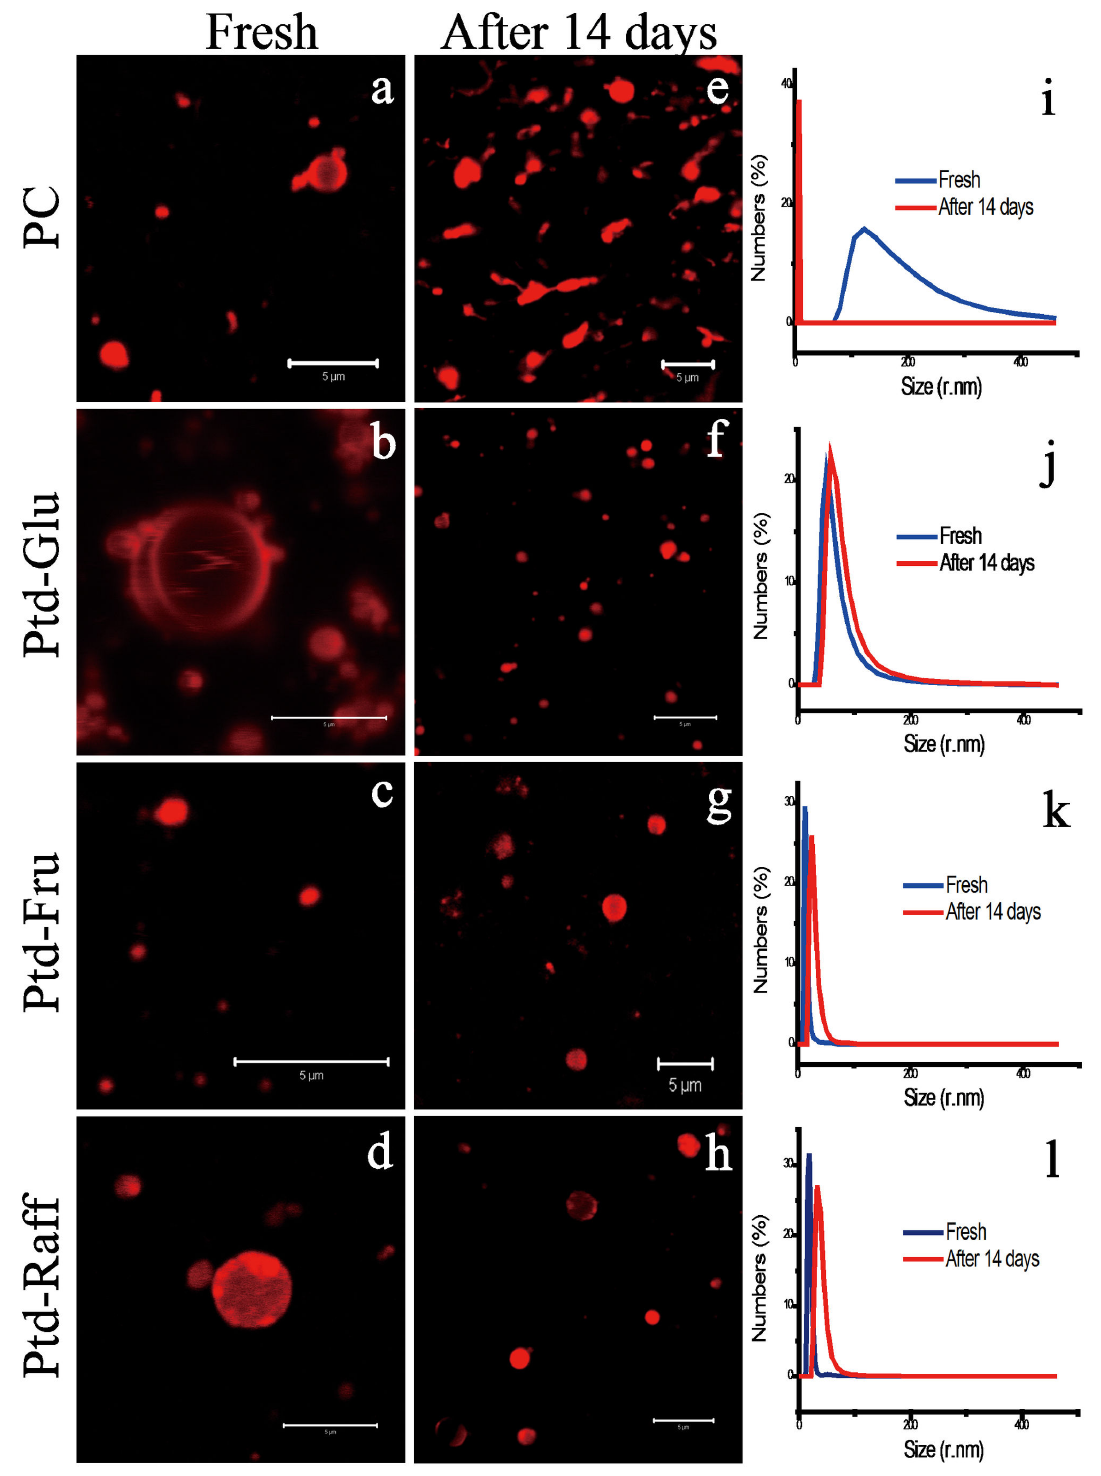
Figure 4. Characterization of nanoliposomes of PC, Ptd-Glu, Ptd-Suc and Ptd-Raff following prolonged storage by CLSM and DLS. (a-d) Morphology of freshly prepared nanoliposomes (size bar: 5 µm). (e-h) Morphology of nanoliposomes following storage for 14 days at room temperature (size bar: 5 µm). (i-l) Size dispersion of freshly prepared nanoliposomes and nanoliposomes stored for 14 days. doi: 10.1371/journal.pone.0073891.g004 PLOS ONE |